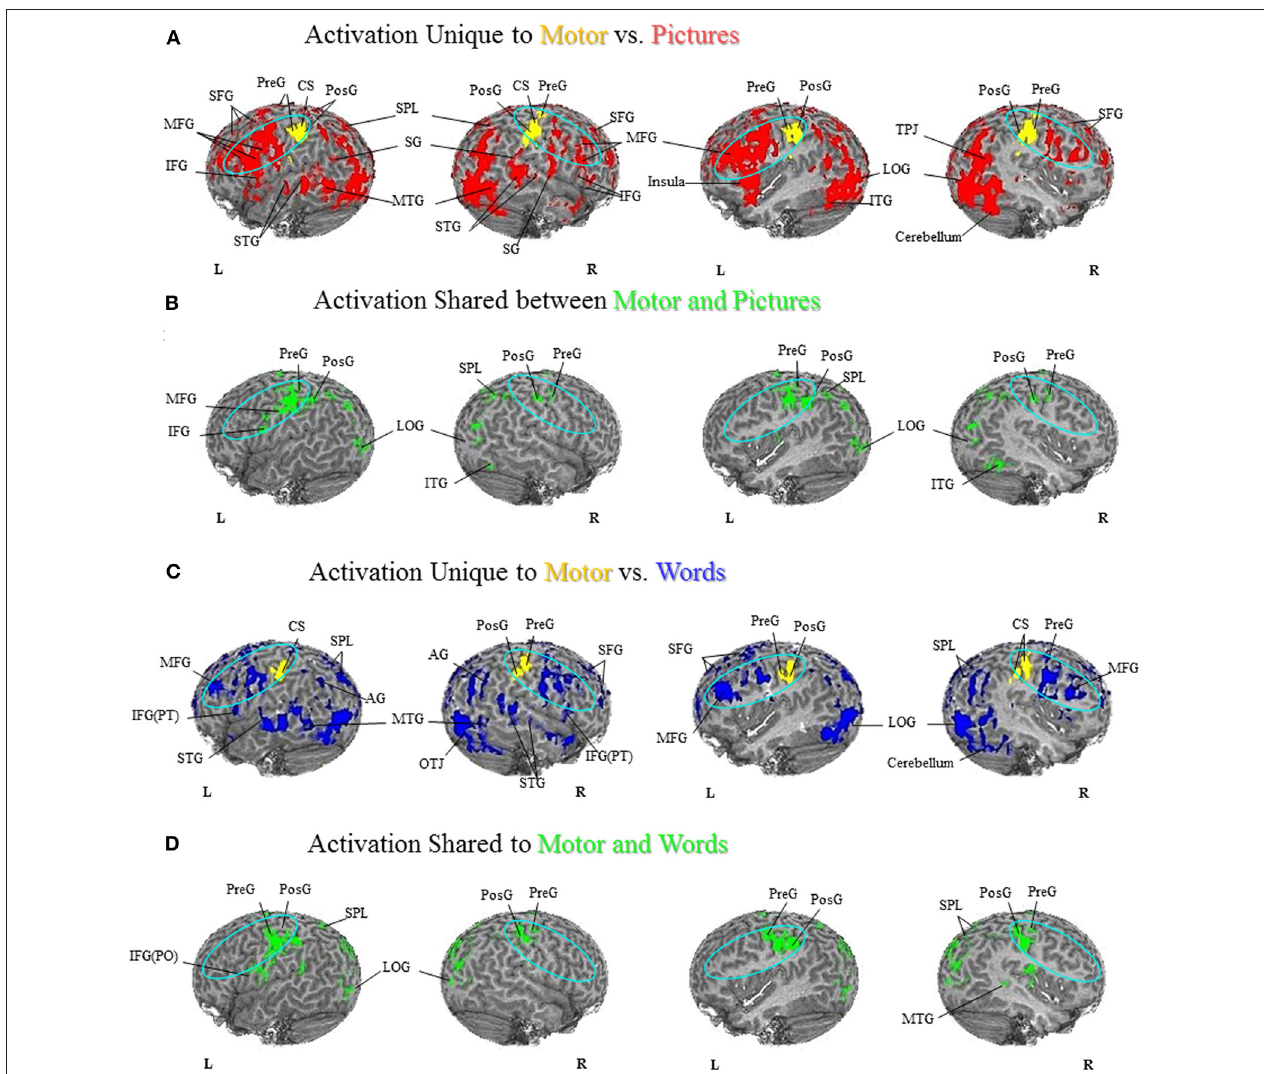
the PFN were found in the bilateral LOG and right ITG. (C) Activation Unique to Motor vs. Words. Activation unique to the motor localization task (yellow coded activation) was found in bilateral PreG and PosG. For the semantic generation to hand word stimuli (blue coded activation), activation was found in bilateral MFG, SFG, IFG(PT), SPL, and left AG, as well as right IPL. Regions of unique activation for the semantic generation to hand word stimuli outside the PFN were found in bilateral STG, MTG, LOG, as well as right cerebellum. (D) Activation Shared between Motor and Words. Shared activation between the motor localization and semantic generation to hand word stimuli (green coded activation) was found in bilateral PreG, PosG, and SPL, and the left SG and IFG(PO). Regions of shared activation between the motor localization task and semantic generation to words outside the PFN were found in bilateral LOG, and right